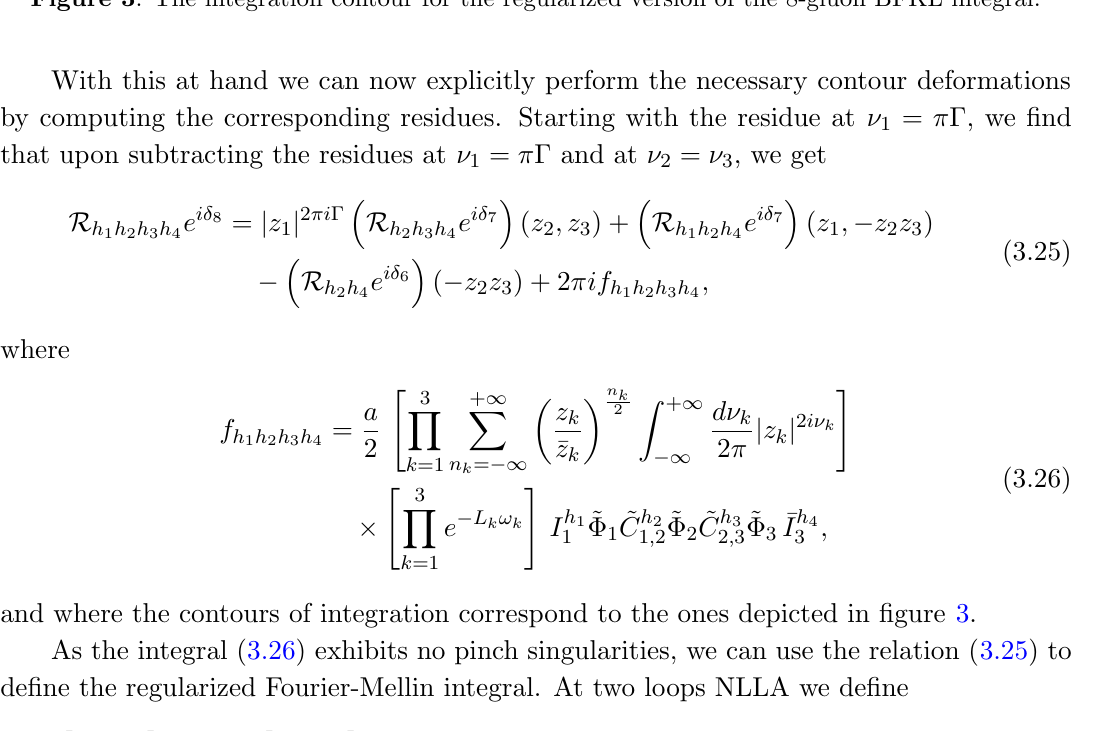
Figure 3 . The integration contour for the regularized version of the 8-gluon BFKL